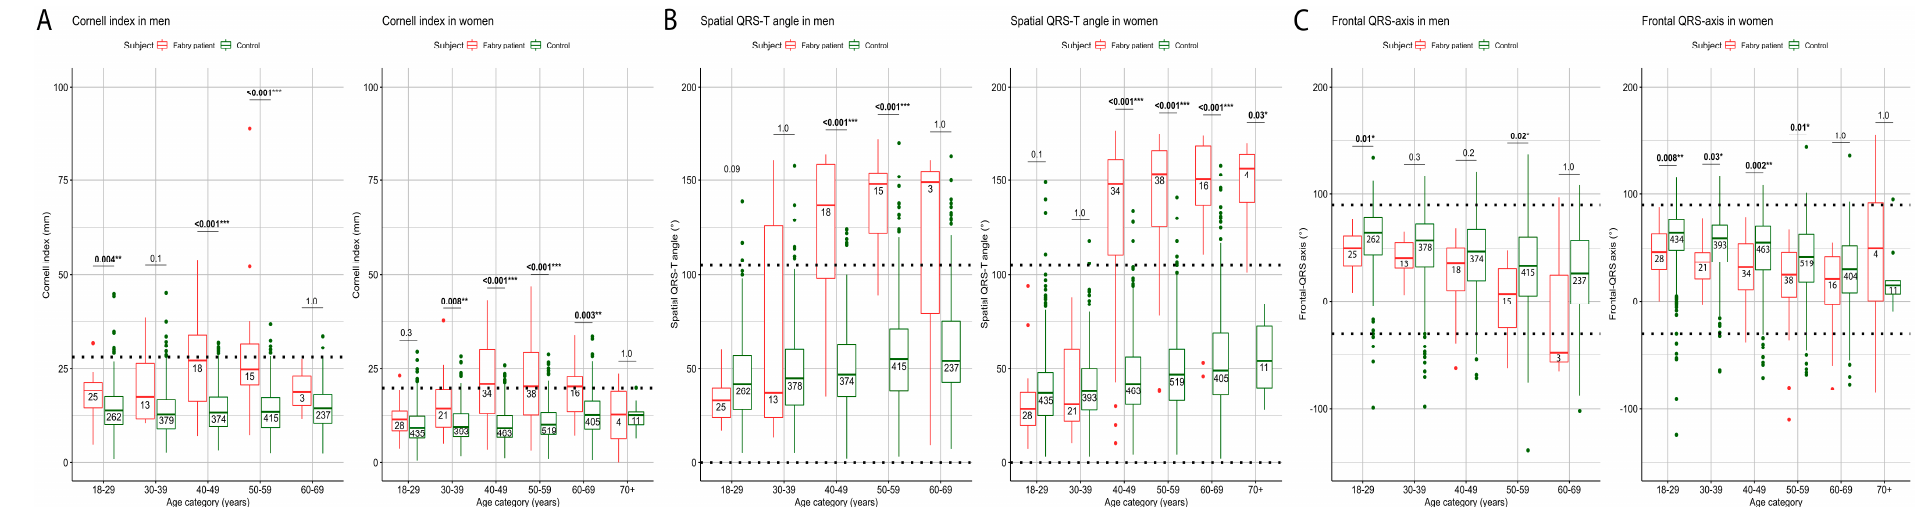
Figure 3. Boxplots of ( A ) P-wave duration, ( B ) PR-interval, ( C ) QRS-duration and ( D ) QTc per age decade in Fabry patients and controls. Numbers inside the boxes are the numbers of the analyzed ECGs. The last available ECG per FD patient per decade was selected to ensure that the influence of repeated measurements was limited. The horizontal lines represents the reference ranges of each ECG parameter, based on the literature. * p < 0.05, ** p < 0.01, *** p < 0.001.